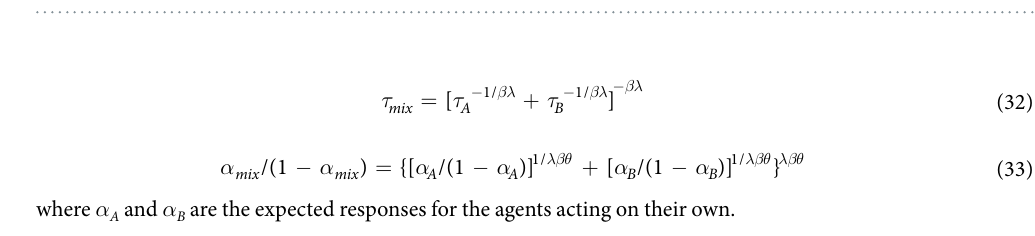
Table 2. List of biodiesel (FAME) properties made from sunflower